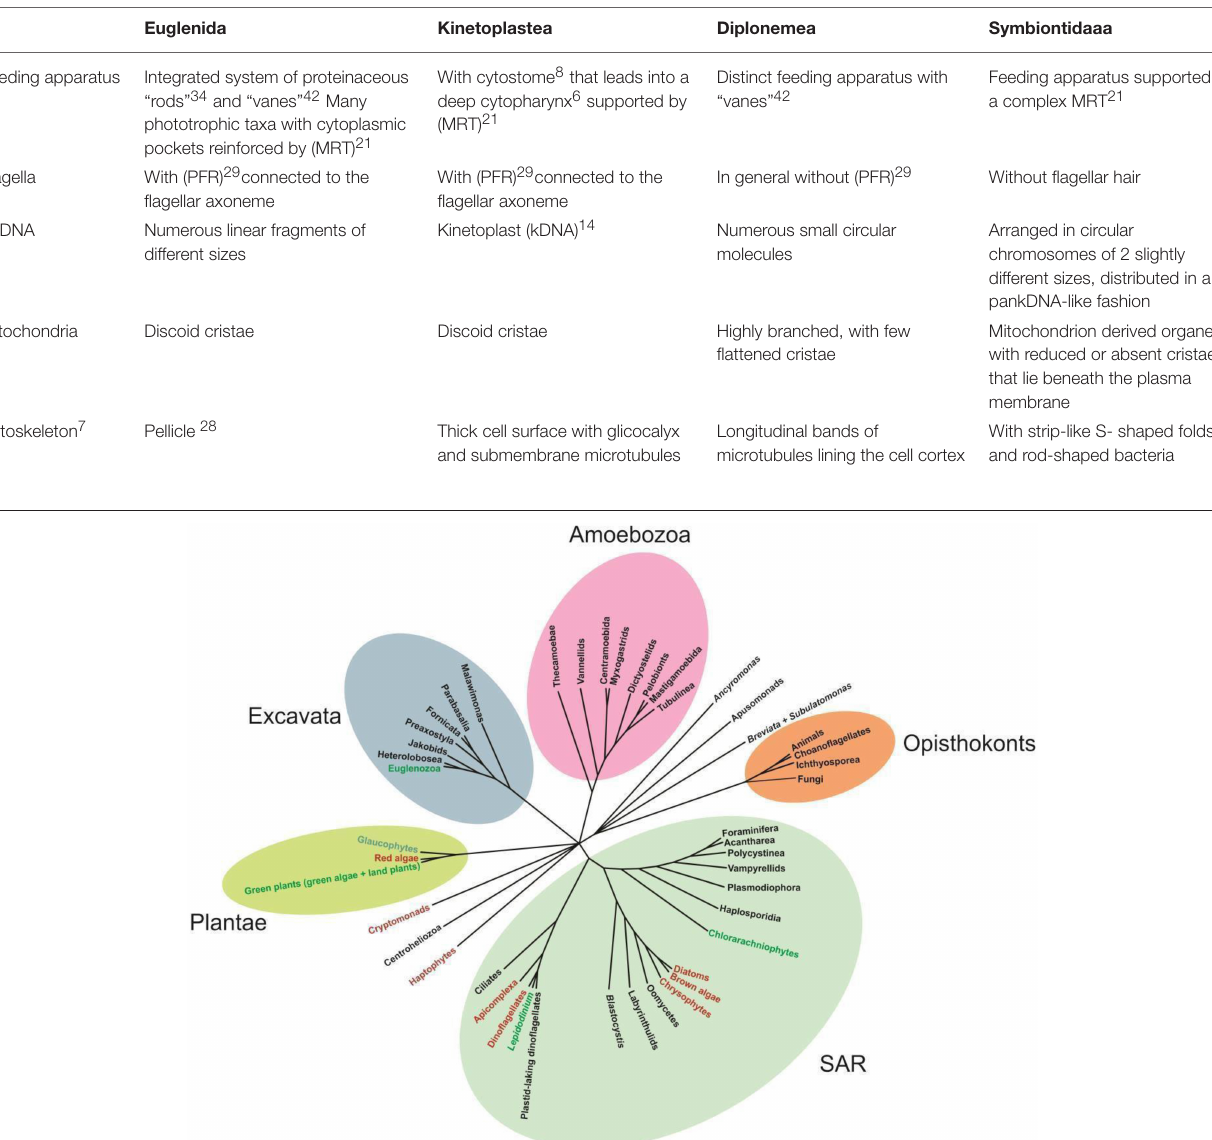
TABLE 1 | Main differences among Euglenida, Kinetoplastea, Diplonemea, and Symbiontida (numbers following some terms correspond to their definitions in the glossary at the end of the text).